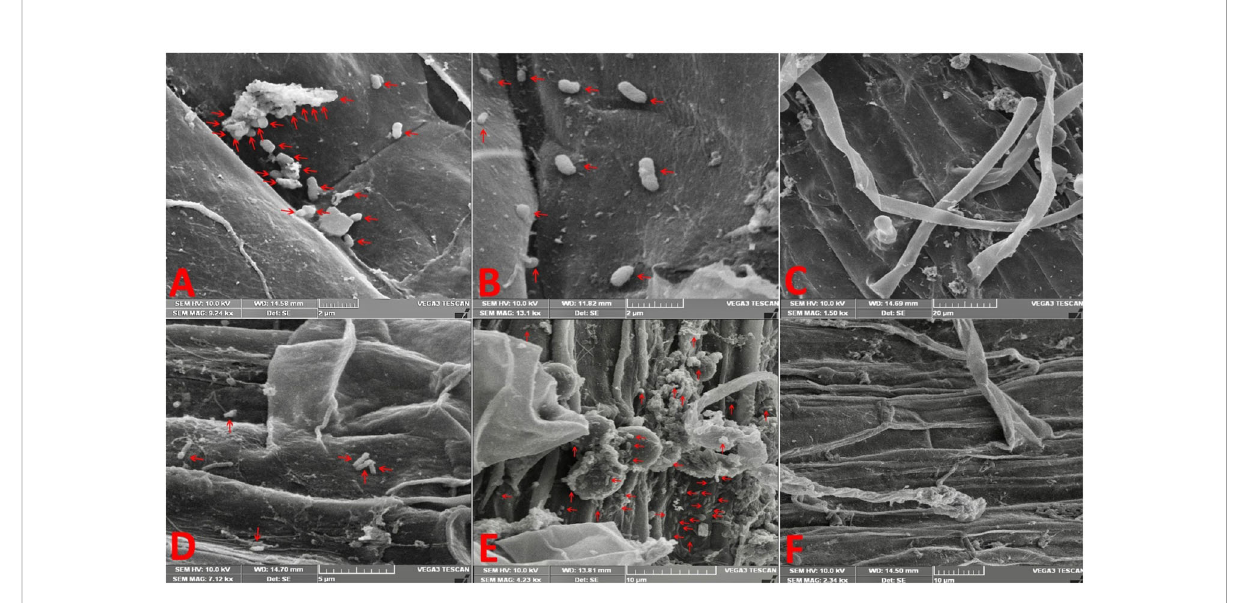
FIGURE 1 Electron micrographs reveal the adherence of bacteria on the root surface at 120 h after inoculation. (A) Rice root inoculated with Gluconacetobacter diazotrophicus (GAB), (B) rice root inoculated with Bradyrhizobium japonicum (BRH), (C) rice control (uninoculated root), (D) soybean root inoculated with GAB, (E) soybean root inoculated with BRH, and (F) soybean control (uninoculated